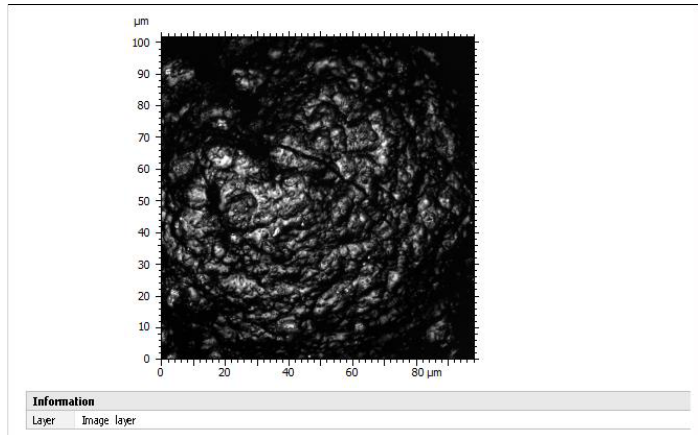
Figure 8. Lignin particle under the confocal microscope (×100) .